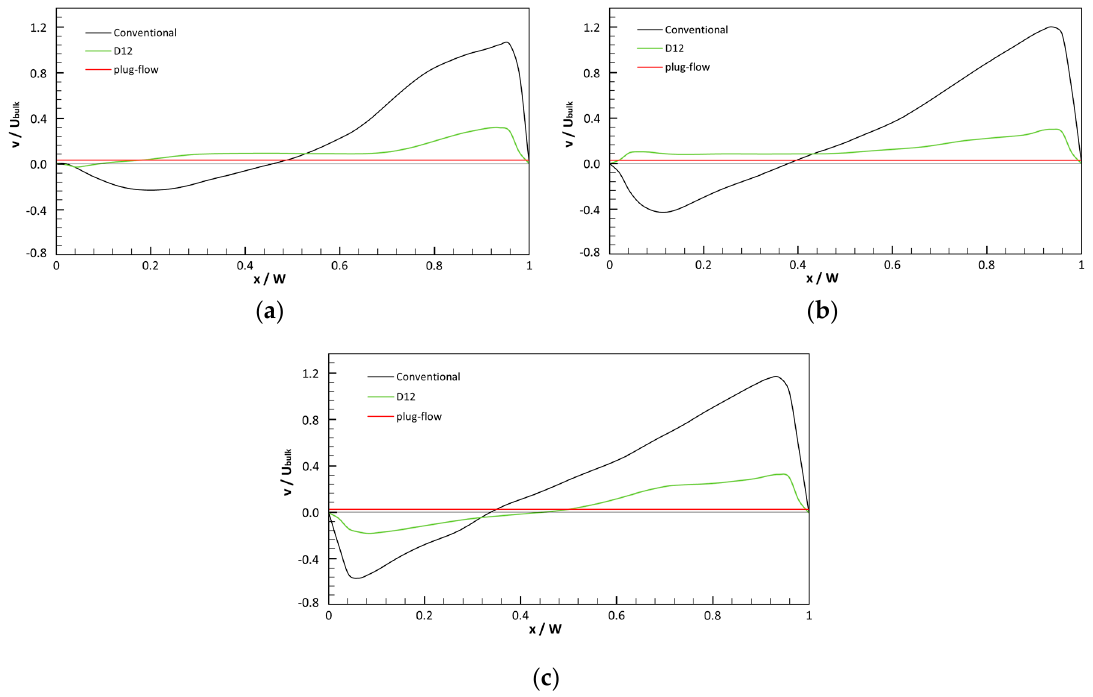
Figure 8. Distribution of vertical velocity component across the chamber width of conventional and D12 designs at different depths: ( a ) y/H = 0.27; ( b ) y/H = 0.5; ( c ) y/H = 0.72.